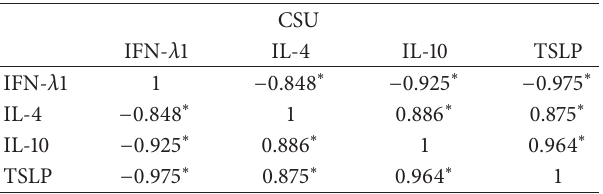
Table 2: The spearman’s rho/correlation coefficient between the plasma level of IFN- 𝜆 1, IL-4, IL-10, and TSLP. ∗ P <